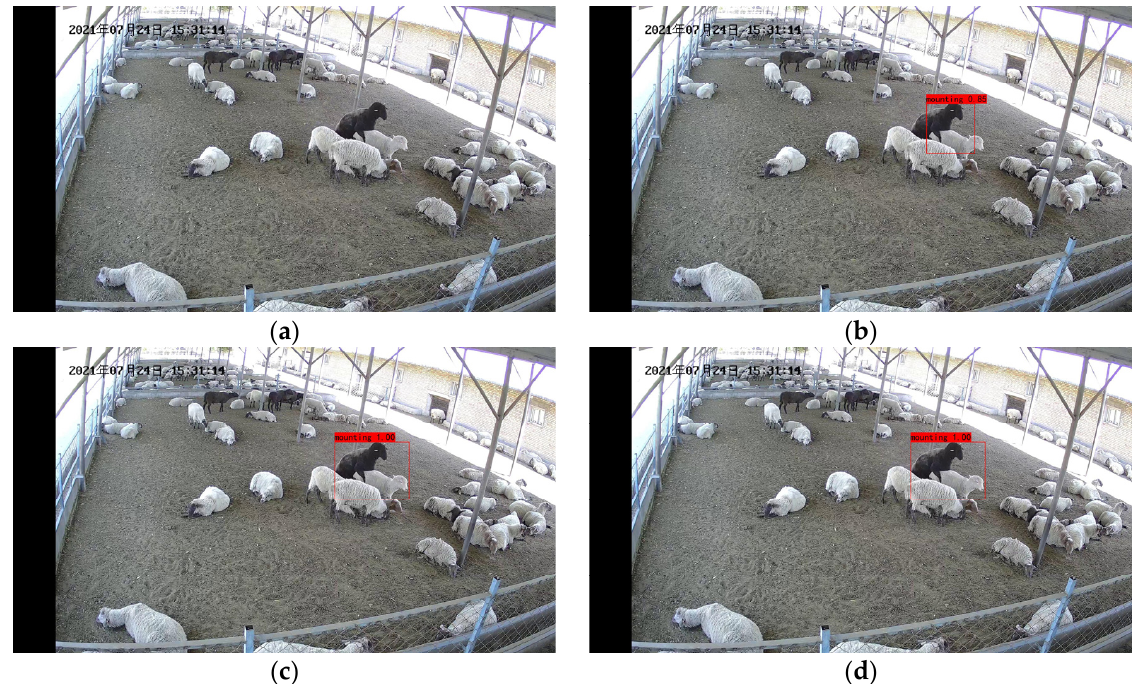
Figure 13. Recognition results in the presence of occlusion: ( a ) Original image; ( b ) YOLOv3 recog- nition results; ( c ) YOLO v4 recognition results; ( d ) Identification results of our model. The Chinese characters in the upper left corner of the image are the date of the video recording, in order of year, month, and day.